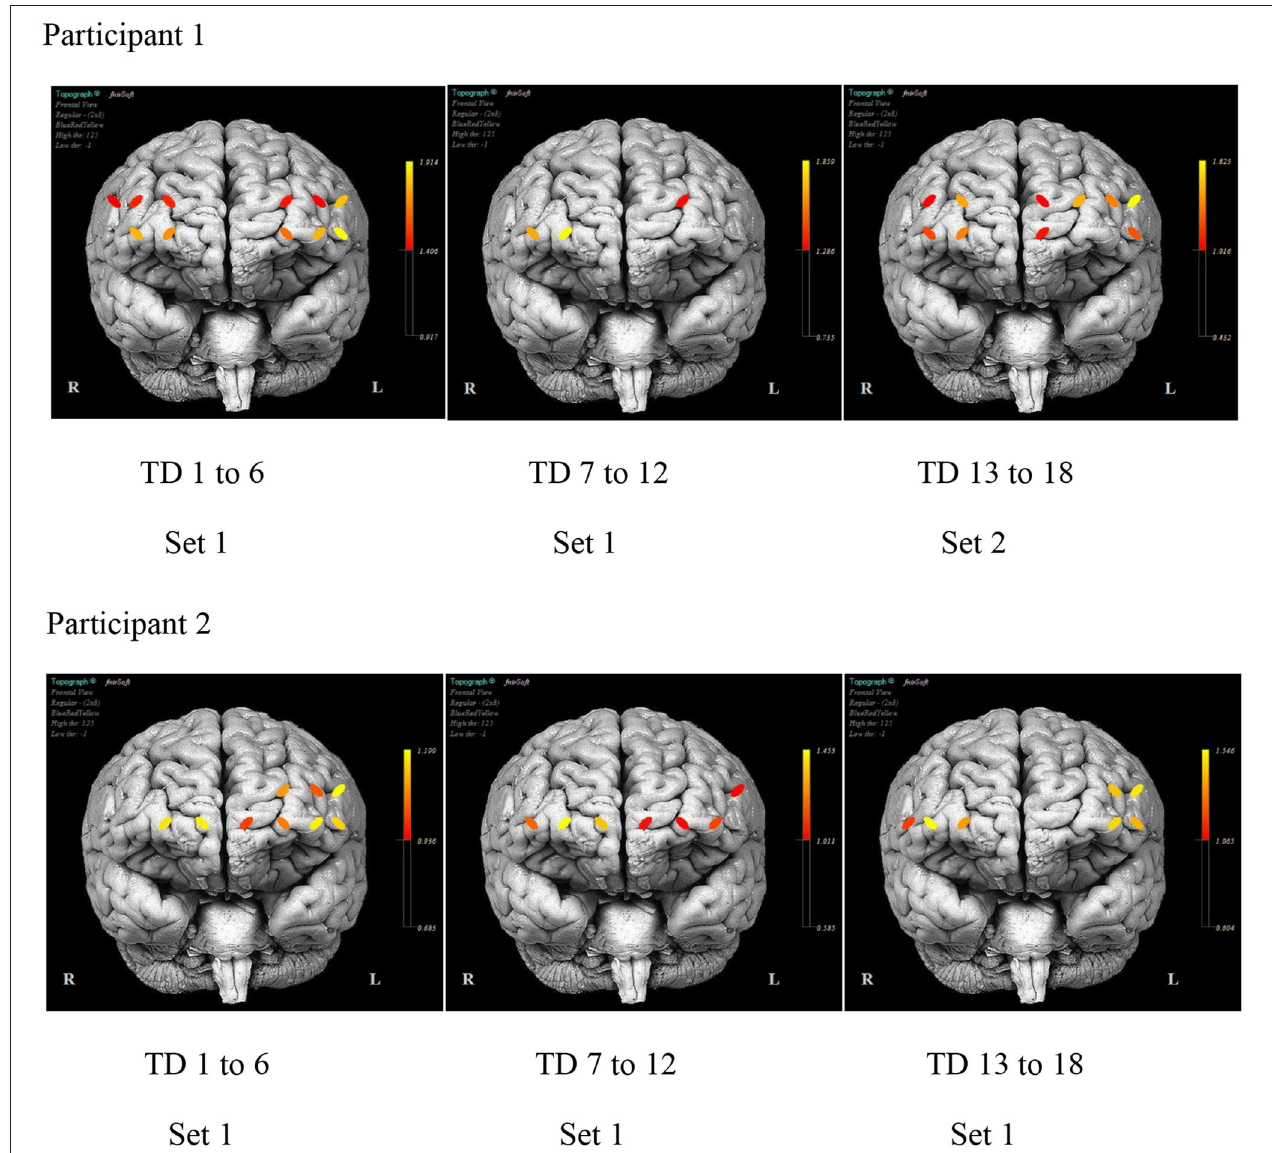
FIGURE 7 | The mean prefrontal cortex activity by optode for selected day ranges for each